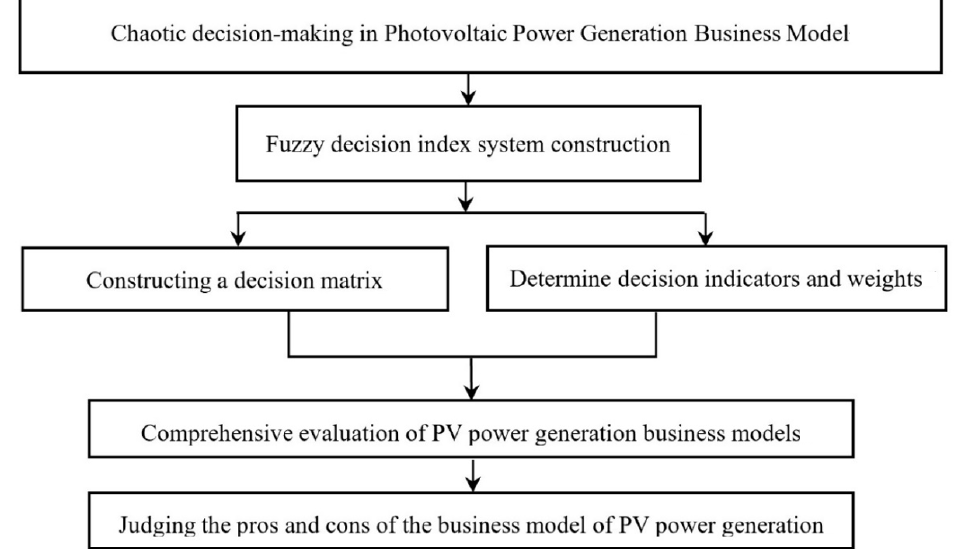
Figure 1. Flow chart for the business model of PV power generation using fuzzy decision method.